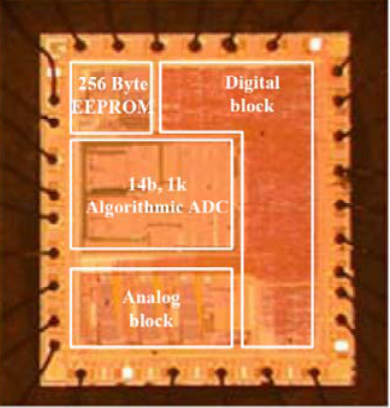
Figure 14. Microscope image of CMOS fabricated capacitive readout circuit.